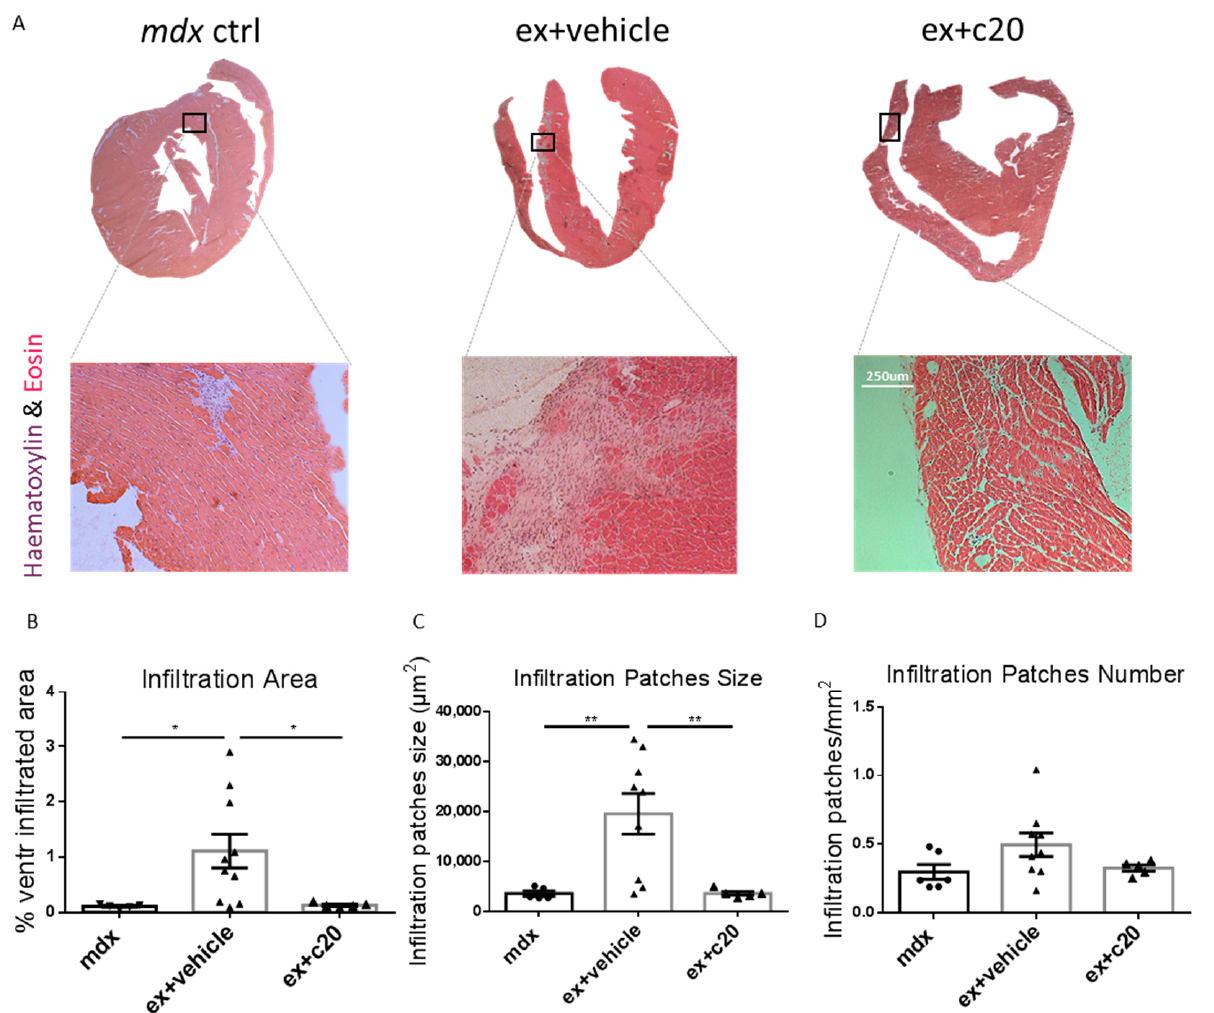
Figure 3. Decreased cell infiltration area in C20-treated exercised mdx . ( A ) Representative H&E staining showing myocardium morphology and the infiltrating cell patches in control mdx and vehicle or C20-treated exercised mdx . ( B ) Quantification of cell infiltration area expressed as percentage over the total ventricular area, as determined in H&E stained cryosections. ( C ) Quantification of the size of cells infiltration patches expressed in µ m 2 . ( D ) Quantification of the number of cells infiltration patches, normalised per mm 2 . Data from ( B , D ) are expressed as mean +/ − S.E.M.; n = 5, 9, five independent samples per group. All quantifications were calculated using ImageJ software, * p < 0.05, ** p < 0.01, ordinary one-way ANOVA with Bonferroni correction for multiple comparisons. Since immune cell infiltration might be triggered by necrotic cell death of cardiomy- ocytes [47,48], we analysed ventricular cardiomyocyte necrosis in C20 or vehicle-treated ex mdx by immune-staining of the ventricle cryosections with anti-mouse IgG conjugated to a TRITC fluorochrome. As shown in Figure 4A,B, the necrotic ventricle area was significantly reduced in the C20 treated mice compared with vehicle-treated controls, with levels com- parable to unexercised age-matched mdx . Taken together, these results demonstrated that C20 treatment ameliorates dystrophic heart phenotype in the ex mdx model by reducing immune cell infiltration and cardiomyocyte